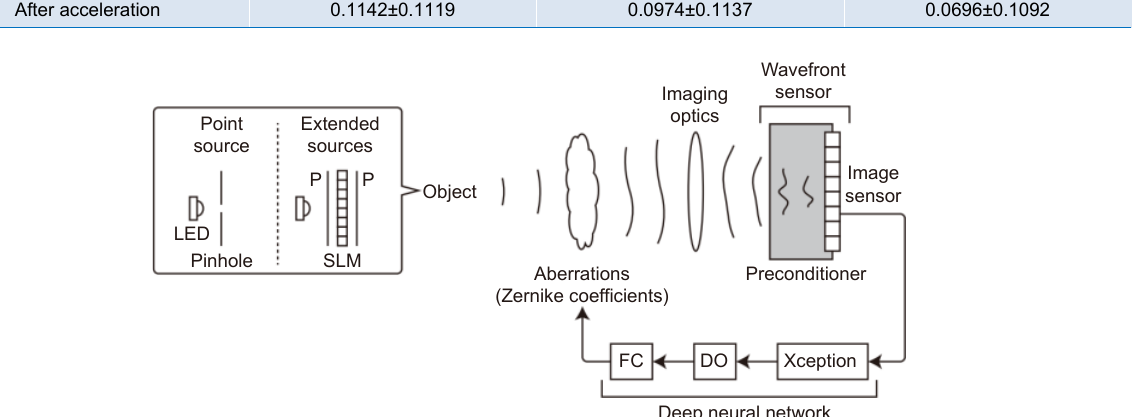
Fig. 12 | Schematic and experimental diagram of the deep learning wavefront sensor. LED: light emitting diode. P: Polarizer. SLM: Spatial light modulator. DO: Dropout layer. FC: full connection layer. Figure reproduced from ref. 83 , Optical Society of